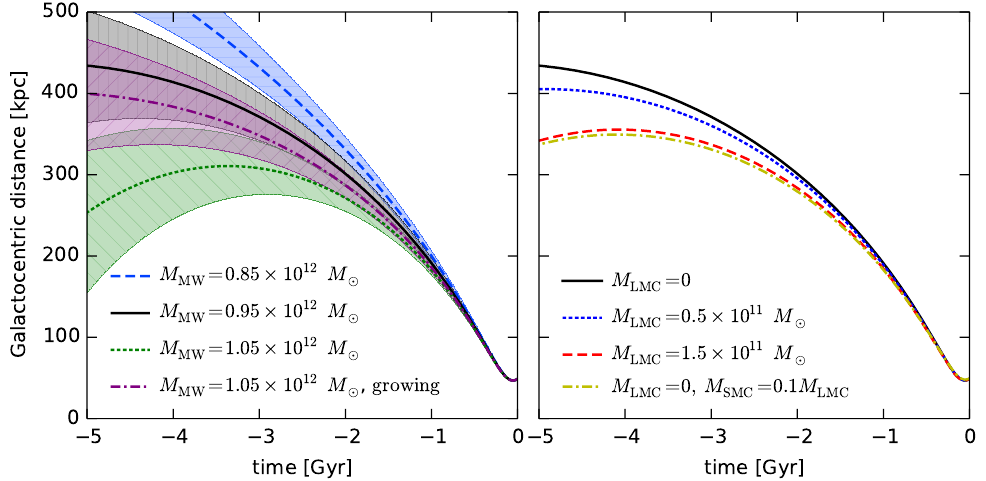
Figure 3. Past trajectory of the LMC for different choices of the Milky Way potential (left panel) or LMC mass (right panel). The black curve corresponds to the fiducial potential with M MW = 0.95 10 12 M , M LMC = 0, present-day position and PM taken from Luri et al. [47], × (cid:12) and heliocentric distance of 49.6 kpc [78]. Blue and green curves in the left panel are plotted for a slightly lighter (0.85 10 12 M ) or heavier (1.05 10 12 M ) Milky Way, and the magenta curve × × (cid:12) (cid:12) represents the case when the Milky Way mass grows linearly over the Hubble time. Shaded regions show the 1 σ range of orbits arising from the uncertainty in the present-day position/velocity (chiefly the distance with a 1% error bar). In the right panel, dotted blue and dashed red curves show the tra- jectory of a massive LMC (0.5 10 11 M and 0.5 10 11 M ) in live N -body simulations correspond to × × (cid:12) (cid:12) the same Galactic potential and present-day phase-space coordinates as the black (test-particle) orbit. The dot-dashed yellow curve shows the orbit of a massless LMC, but with present-day coordinates corresponding to the centre of mass of the LMC–SMC system with a mass ratio of